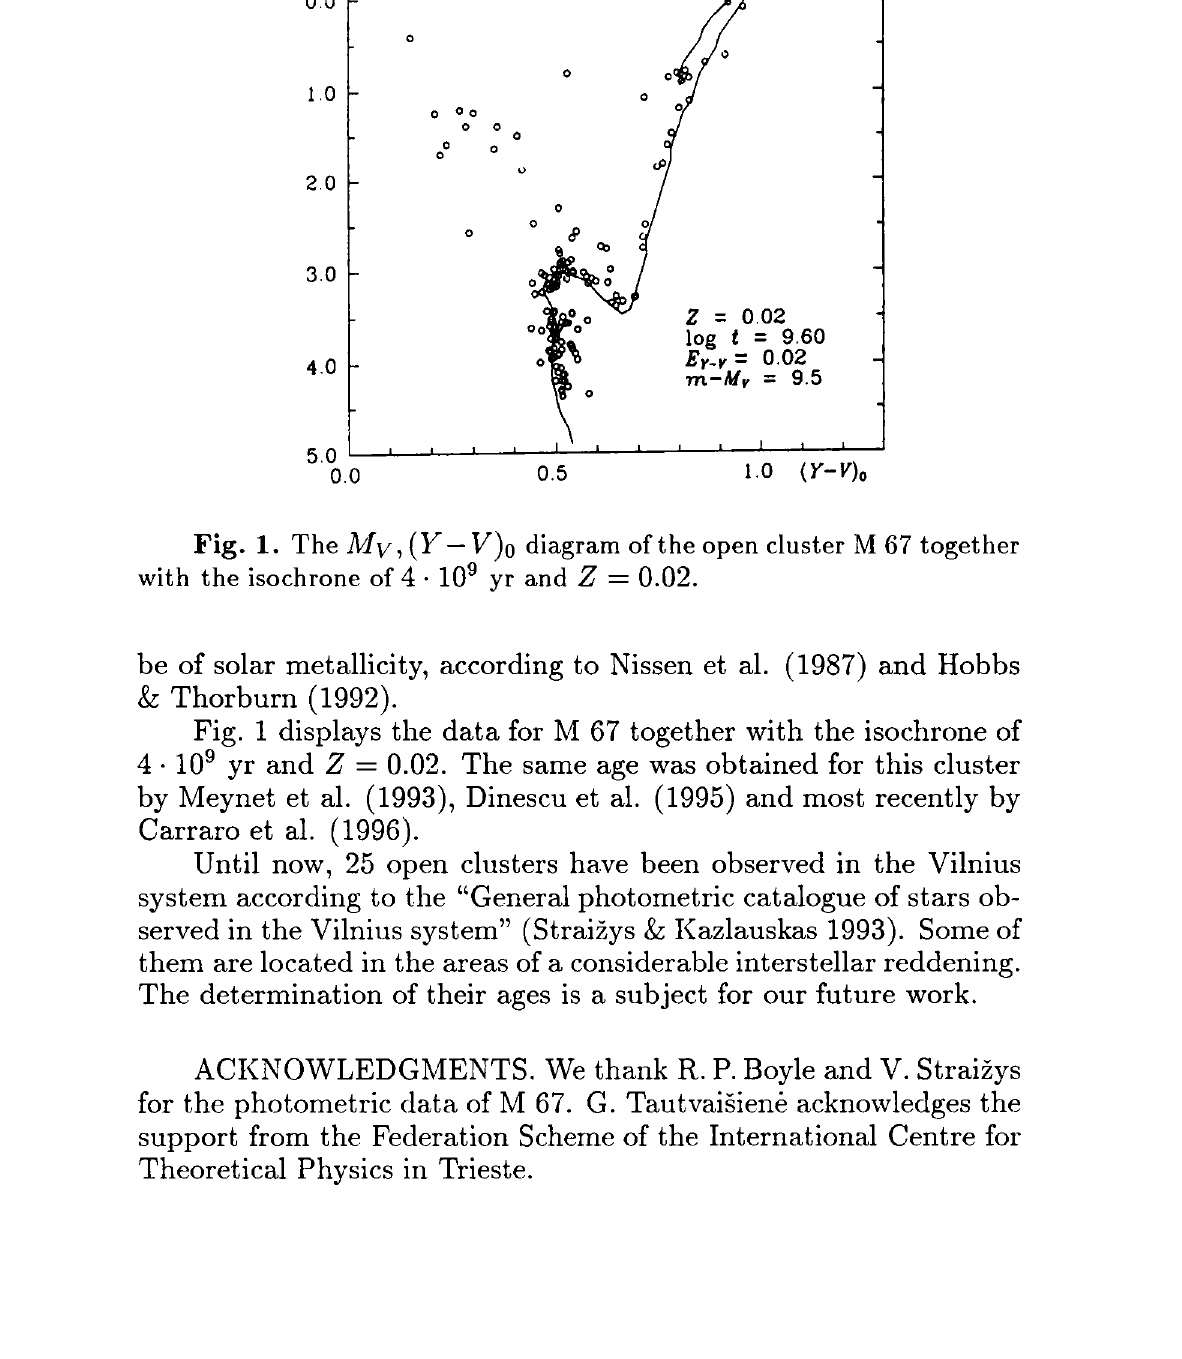
Fig. 1. The My, (Y — V)o diagram of the open cluster M 67 together with the isochrone of 4 • 10 9 yr and Z =